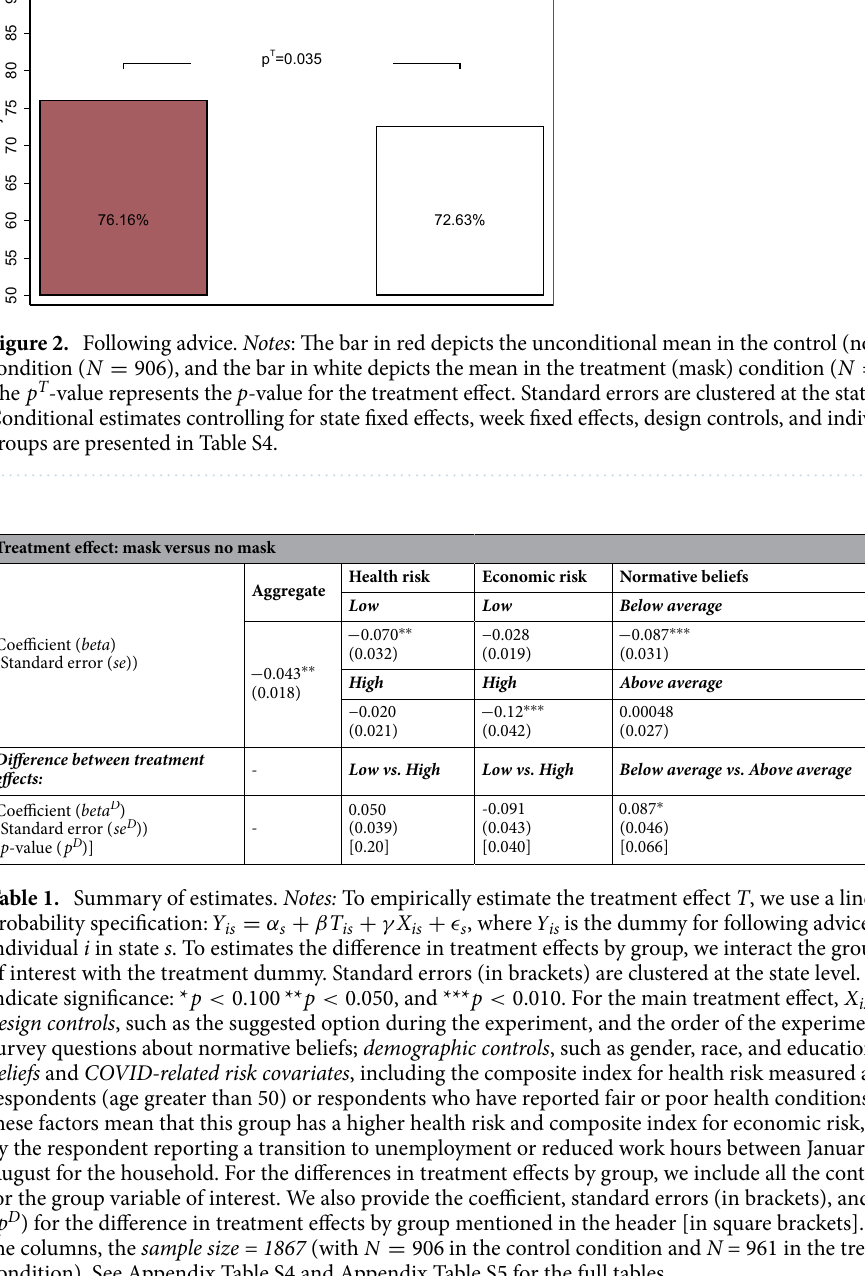
advice given in the preceding video. These—and all the following—results are unconditional, meaning they pro- vide the raw averages across our sample, without controlling for additional variables. We re-estimate all effects controlling for design effects, state and week fixed effects, and individual controls and present the main results in Table 1. Full results, which mirror the findings presented here, and additional robustness analyses using different model specifications, weighting, and alternative measures for our variables of interest can be found in the Online Supplement (Tables S3 and S4). A description of the empirical models can be found in the “Methods” section.